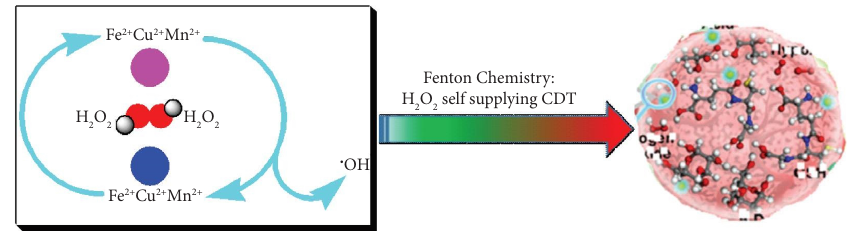
Figure 7: Fenton chemistry of MO 2 as a self-supplying source of O 2 and H 2 O 2